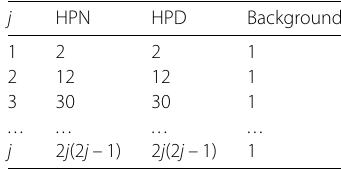
Table 1 Main mathematical features of rational solutions u n and v n of order j j HPN HPD